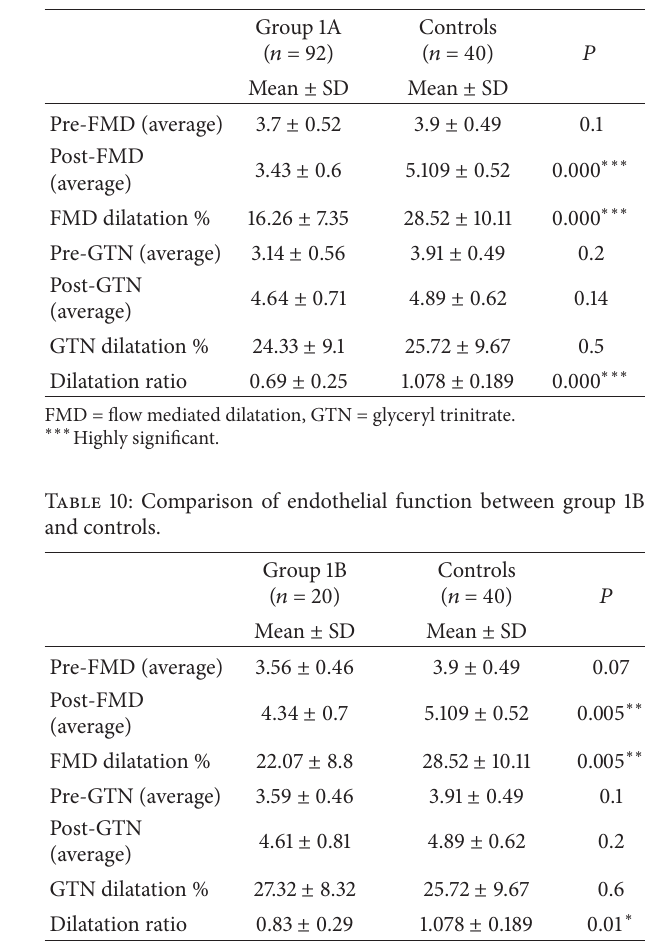
Table 6: Comparison of ultrasonographic duplex findings between group 1B and controls.